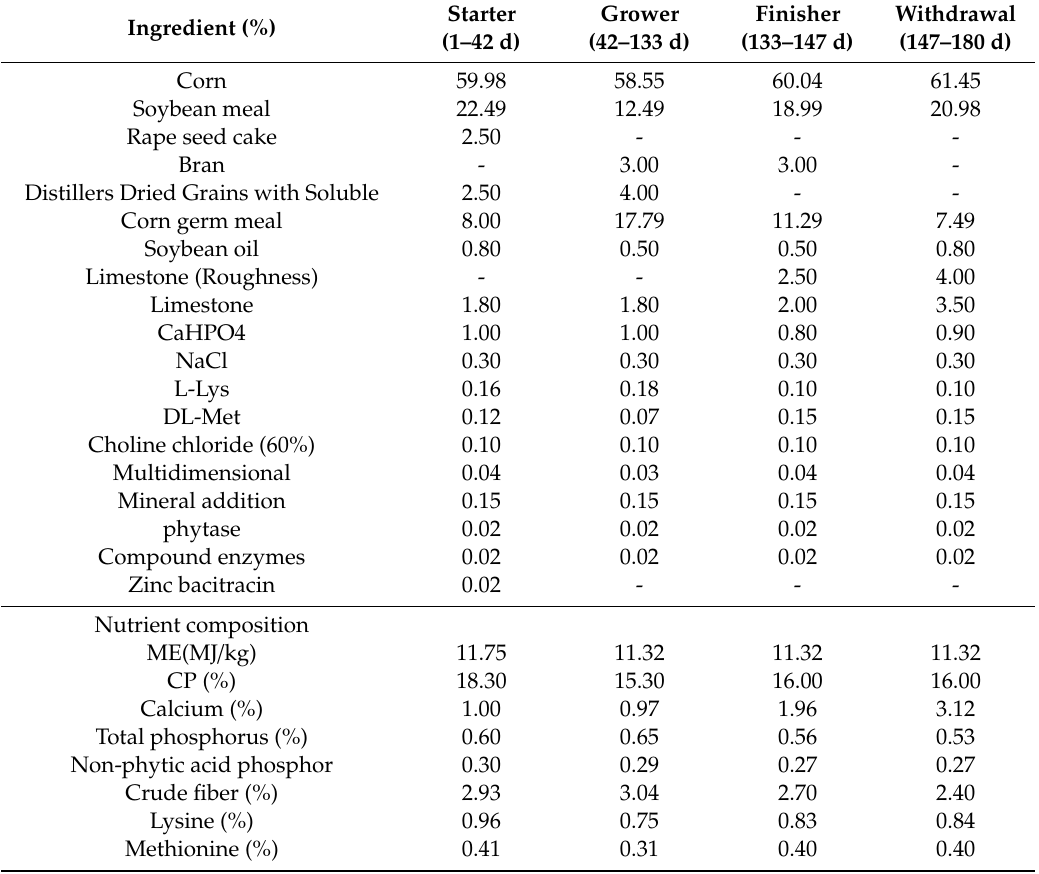
Table 1. Composition of diets distributed during the rearing period for Da-Heng meat type